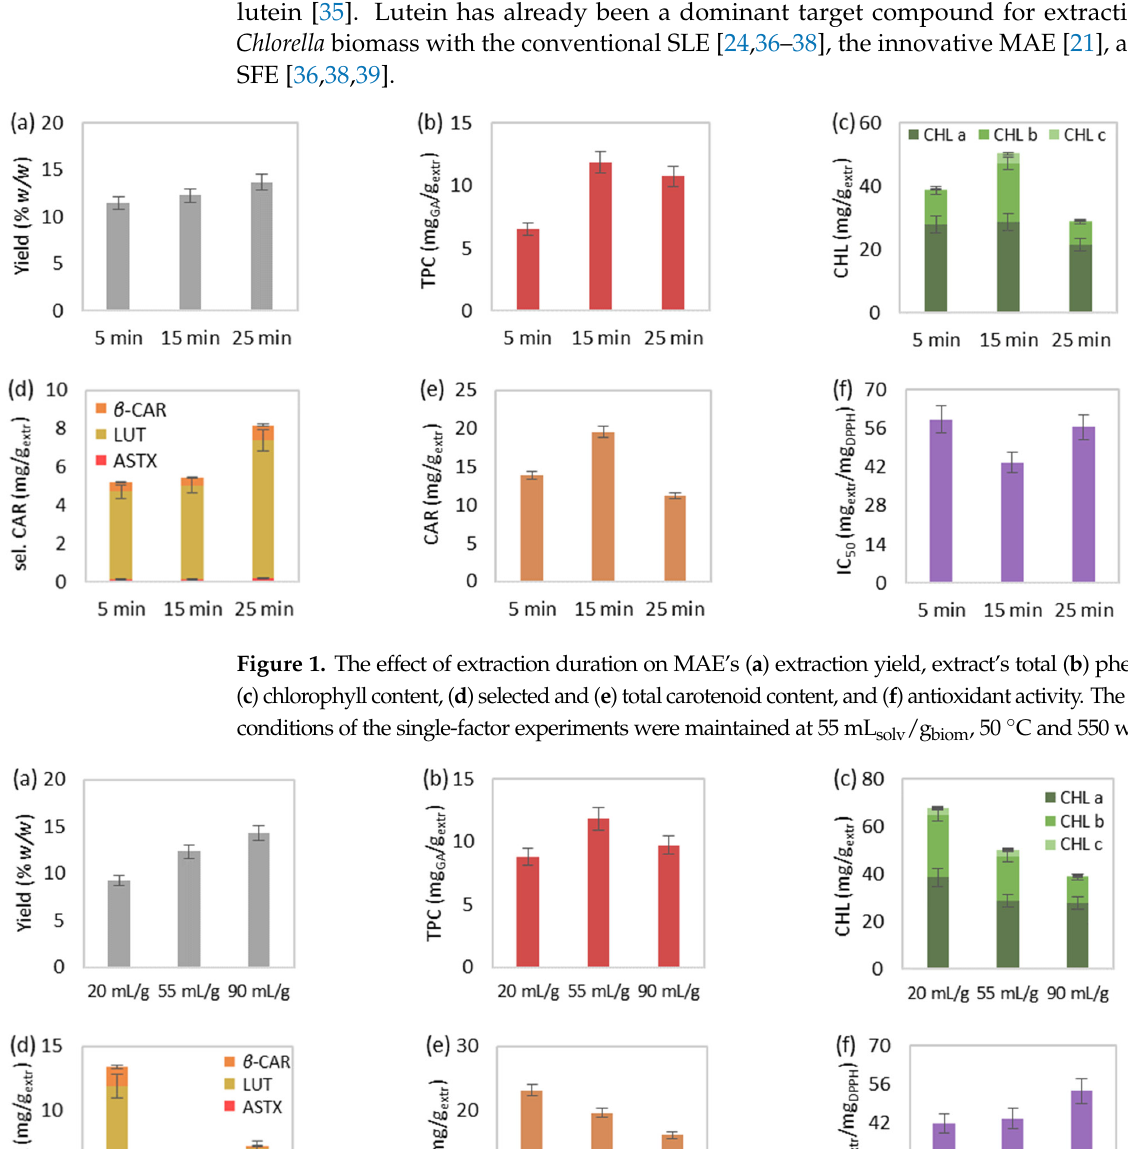
Figure 1. The effect of extraction duration on MAE’s ( a ) extraction yield, extract’s total ( b ) phenolic and ( c ) chlorophyll content, ( d ) selected € ( e ) total carotenoid content, and ( f ) antioxidant activity. The extraction conditions of the single ‐ factor experiments were maintained at 55 mL solv /g biom , 50 °C and 550 watts.